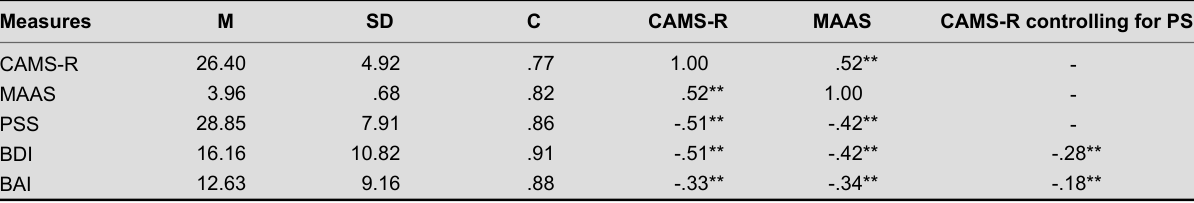
Correlations Between Mindfulness and Related